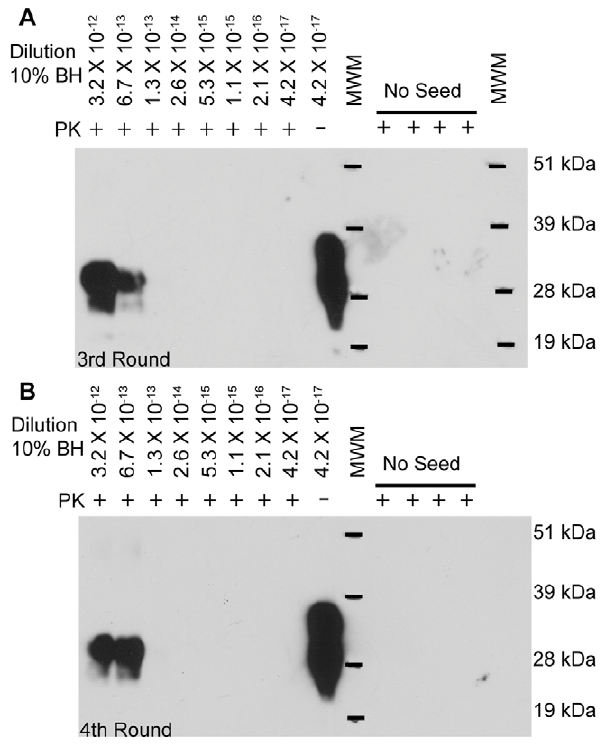
Figure 3. Serial PMCAb allows detection of PrP CWD from femtogram levels of infected brain. CWD-positive BH (10% w/v) was diluted using serial five-fold dilutions in NBH and subjected to serial PMCAb in the presence of 0.05% saponin for four 96-cycle rounds. Results from the (A) third and (B) fourth rounds are shown. No-seed controls contained 100 m L NBH. MWM, molecular weight marker.